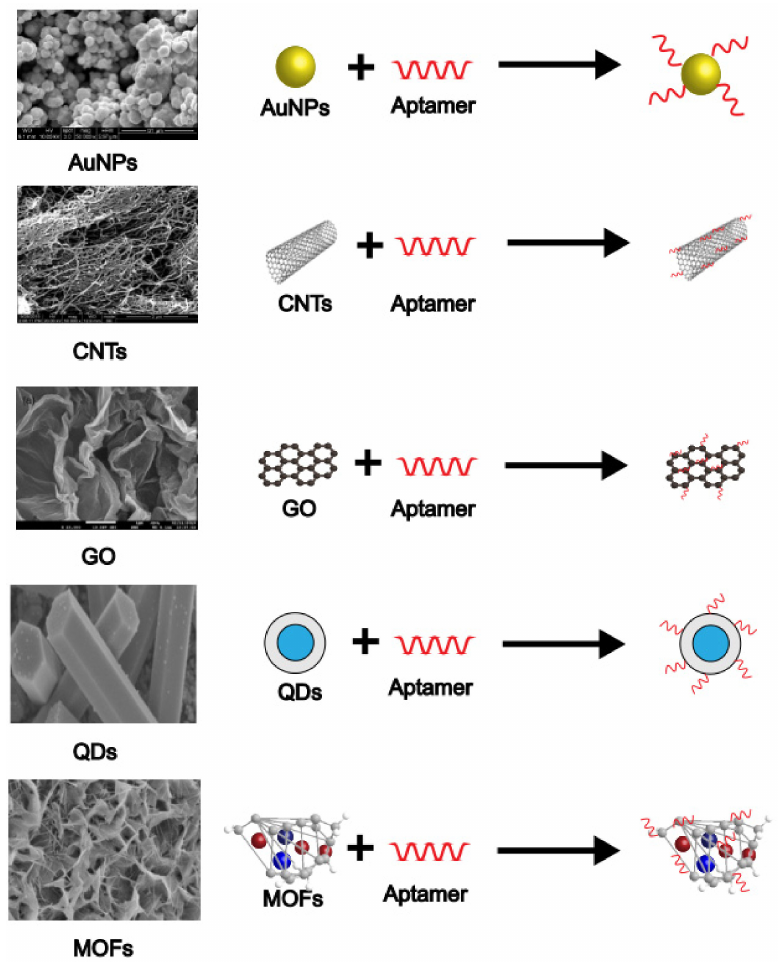
Figure 4. SEM images and combination modes of various